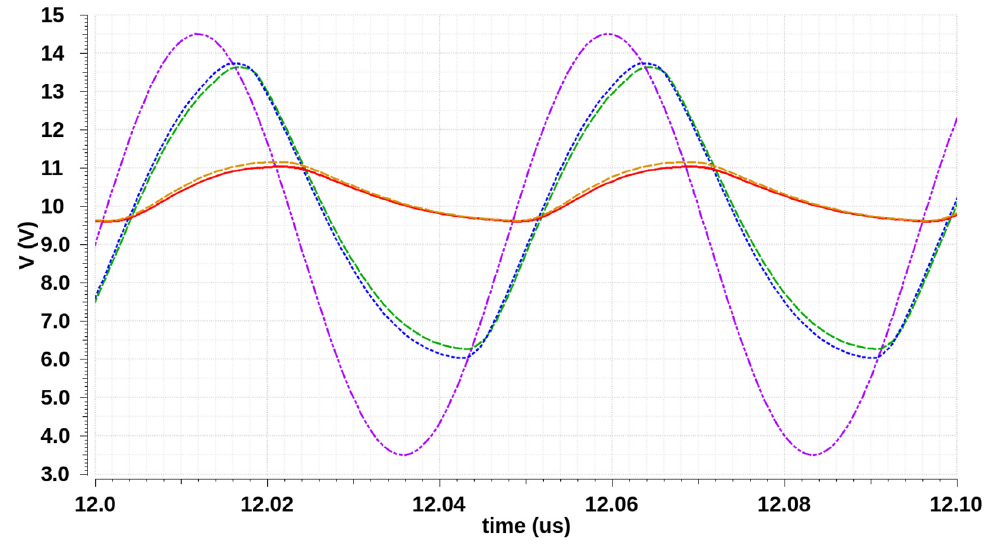
Figure 14. Time-domain comparison of the buffer design stages for input 21 MHz, 5.5 V 0-p amplitude (violet dash-dash-dotted line): the original buffer—blue dotted line; the SOAC buffer—green dashed-dotted line; the laid-out original buffer—orange dashed line; the laid-out SOAC buffer—red solid line.